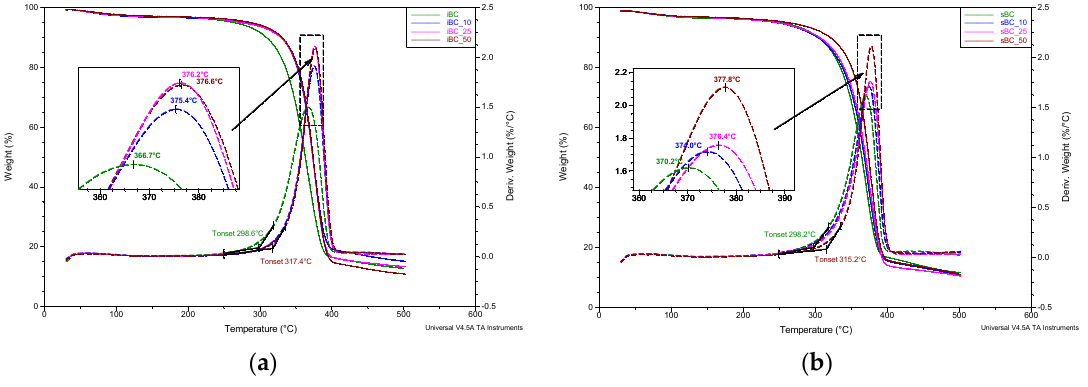
Figure 14. TG and DTG curves of the studied K. intermedius ( a ) and K. sucrofermentans ( b ) bacterial cellulose samples with different levels of GO addition.